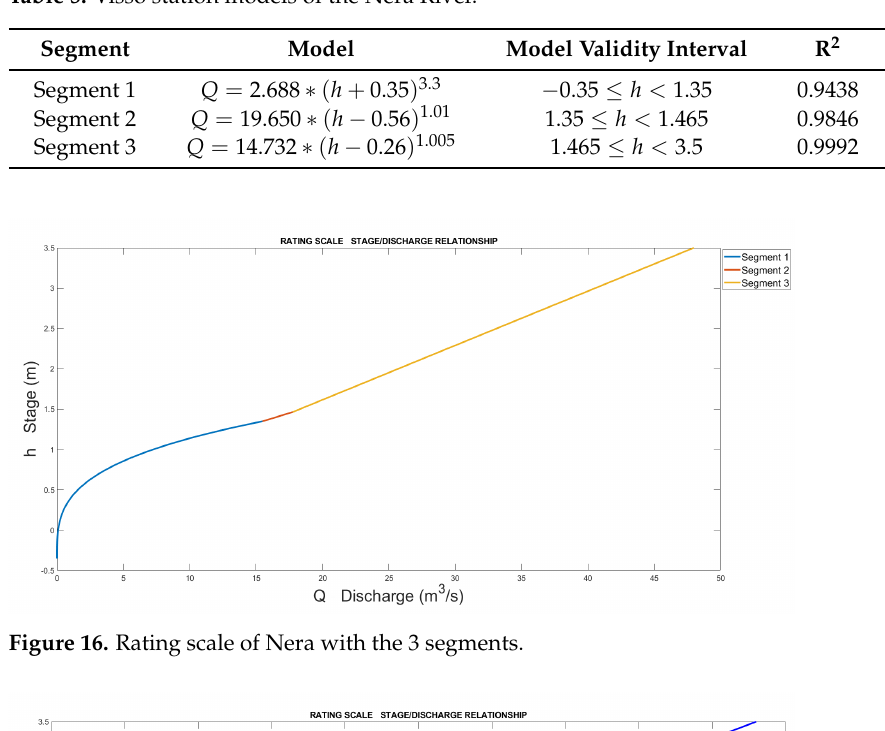
Table 5. Visso station models of the Nera River.